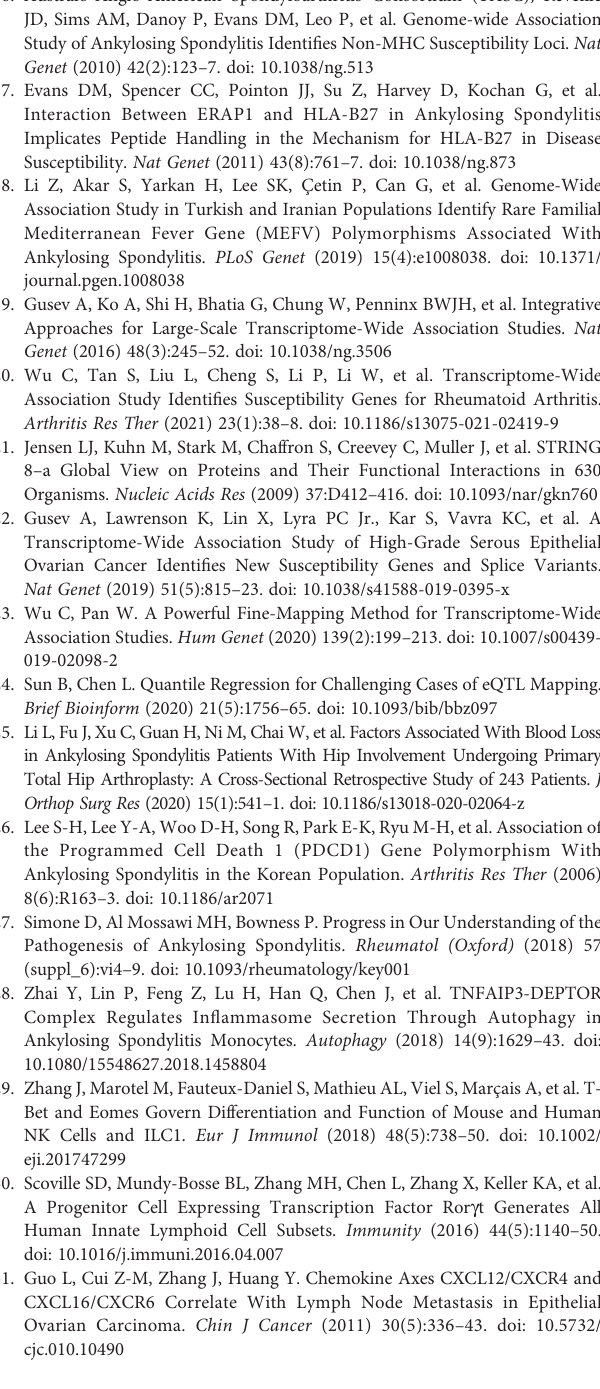
Supplementary Table 2 | AS TWAS detects candidate genes GO and KEGG enrichment analysis results. Supplementary Table 3 | The intersection result of the pathway enrichment analysis result of the common gene and the AS TWAS enrichment